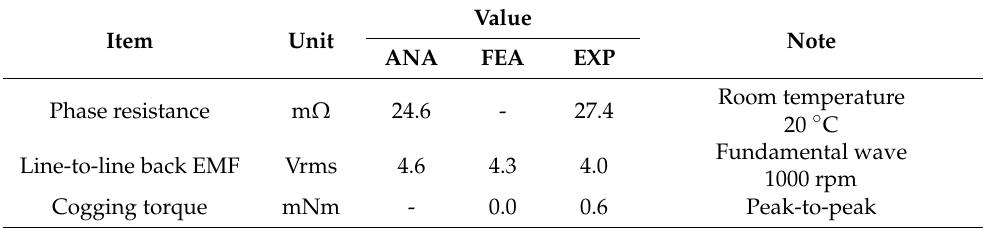
Figure 19. Testing result: ( a ) back EMF, and ( b ) Cogging torque.